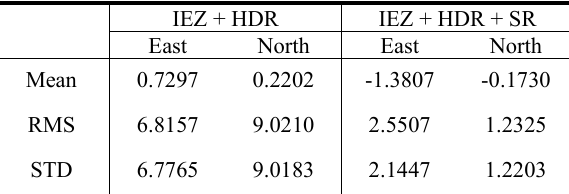
Table 2 . Horizontal positioning errors (Experiment 2).